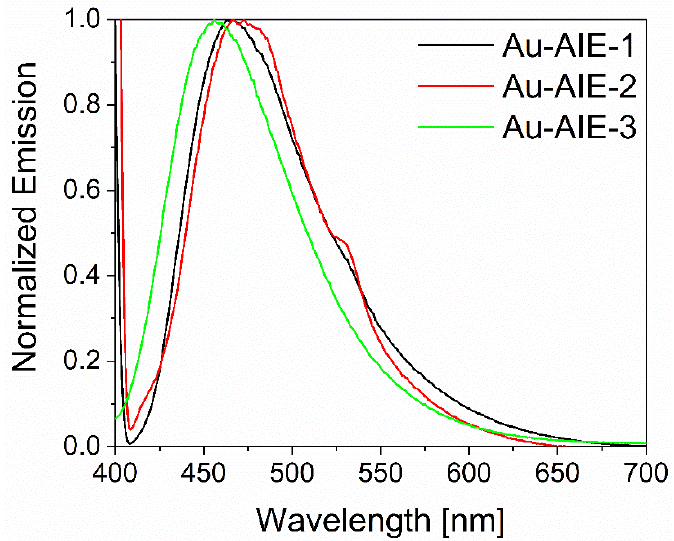
Figure 3. Normalized fluorescence emission spectra of Au-AIE nanoparticles, dispersed in water (excitation wavelength 365 nm). The emission peaks at and below 400 nm are due to scattering from the excitation source.